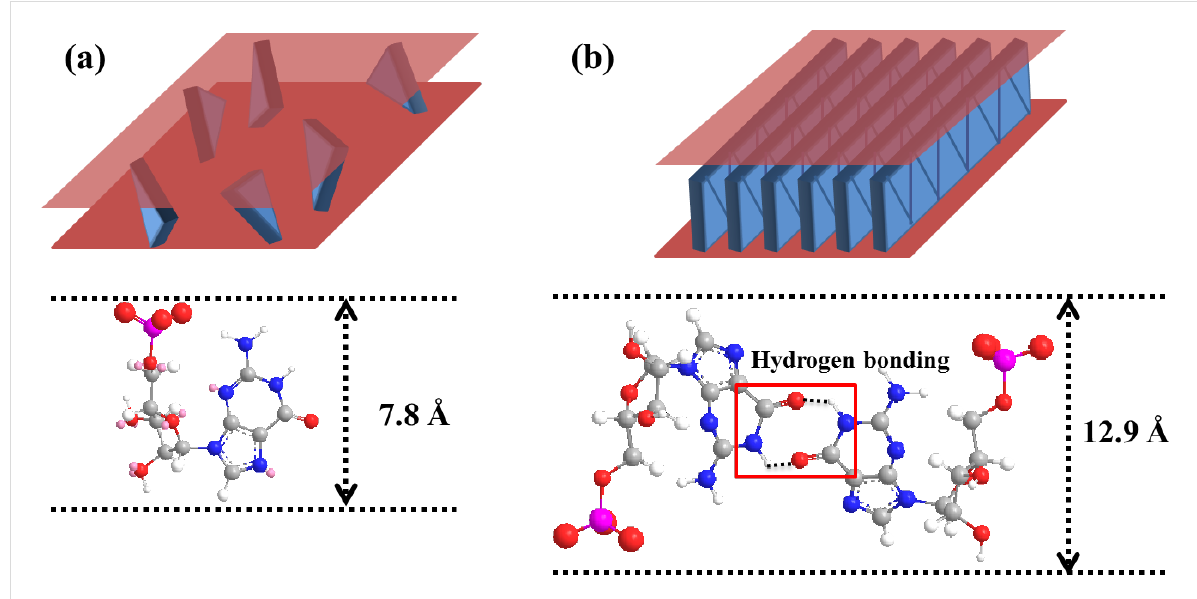
Figure 3: Schematic illustrations for interlayer structure of GMP/LDH hybrids according to molecular arrangement of GMPs: (a) single molecule arrangement (GL-S) and (b) ribbon II arrangement (GL-R).